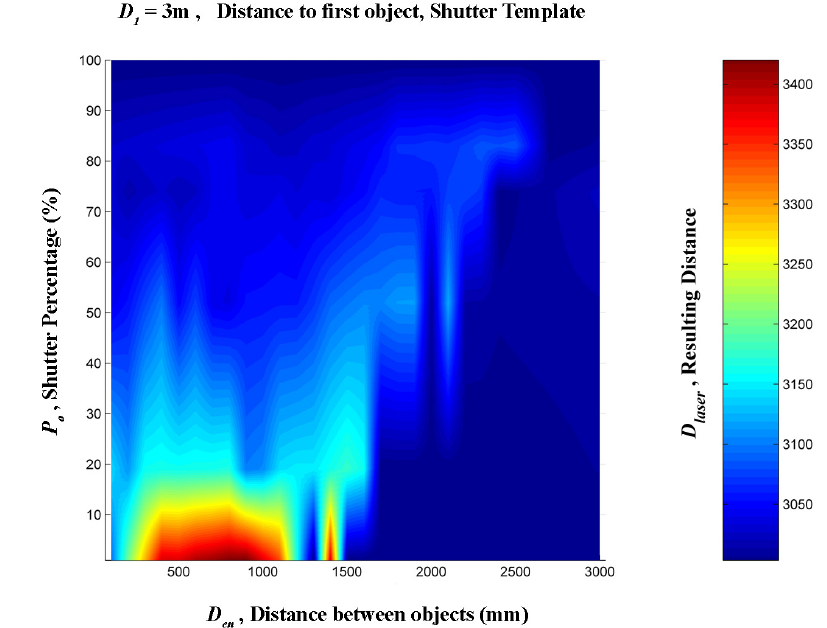
Figure 18. Graphic representation of the distance values (D the results of the progressive blockage of the beam at 90° with the shutter template at a distance (D ) of 3,000 mm from the sensor, with different values of D 1 and 3,000